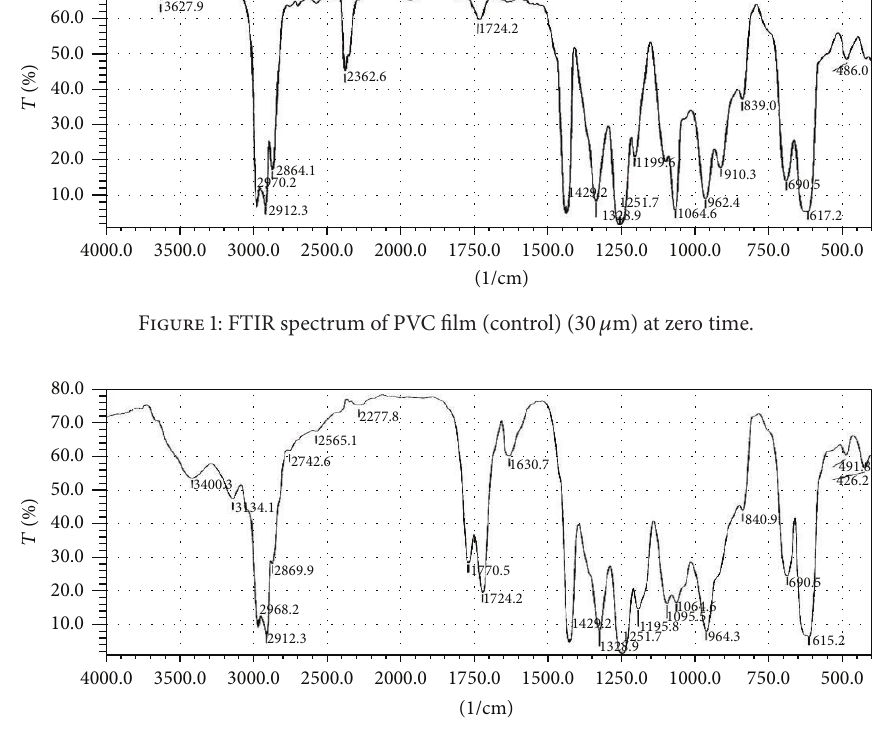
Figure 2: FTIR spectrum of PVC film (control; 30 𝜇 m) after 250